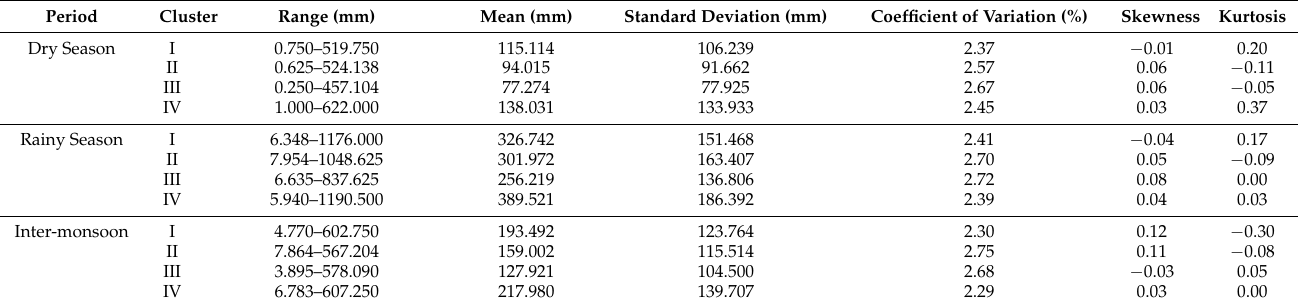
Table 2. Statistics for cluster-wise mean rainfall for the seasonal